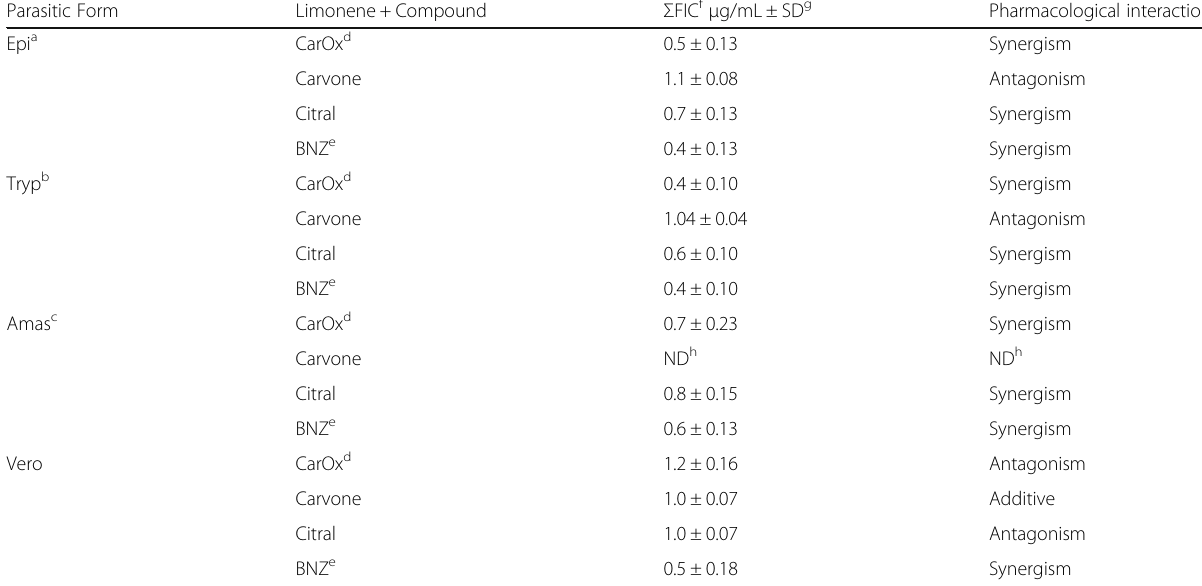
Table 6 Pharmacological interactions among terpenes derived from L. alba Parasitic